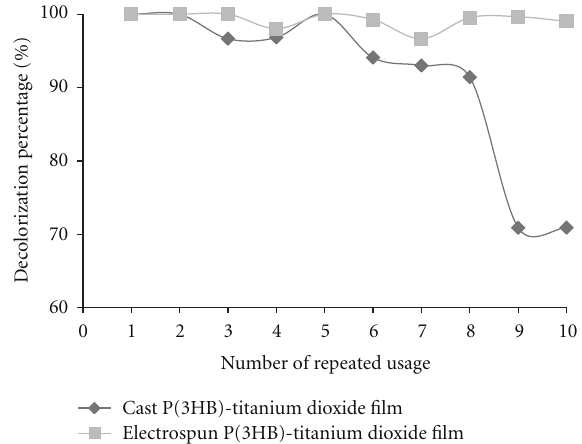
Figure 8: The decolorization percentage of MG in ten repeated decolorization experiments using the same electrospun and cast P(3HB)-50wt% TiO 2 films under solar